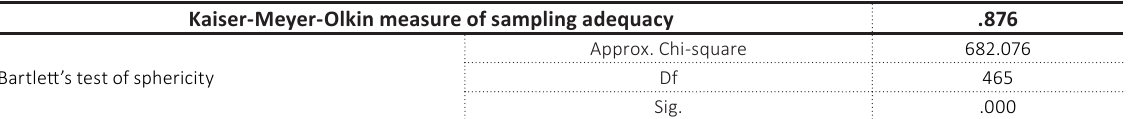
Table 2. KMO and Bartlett’s